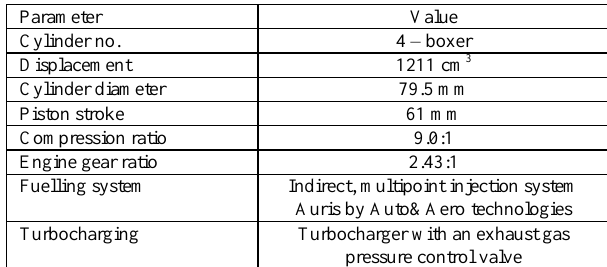
Table. 2 Technical data of CA 912 ULT engine [26]